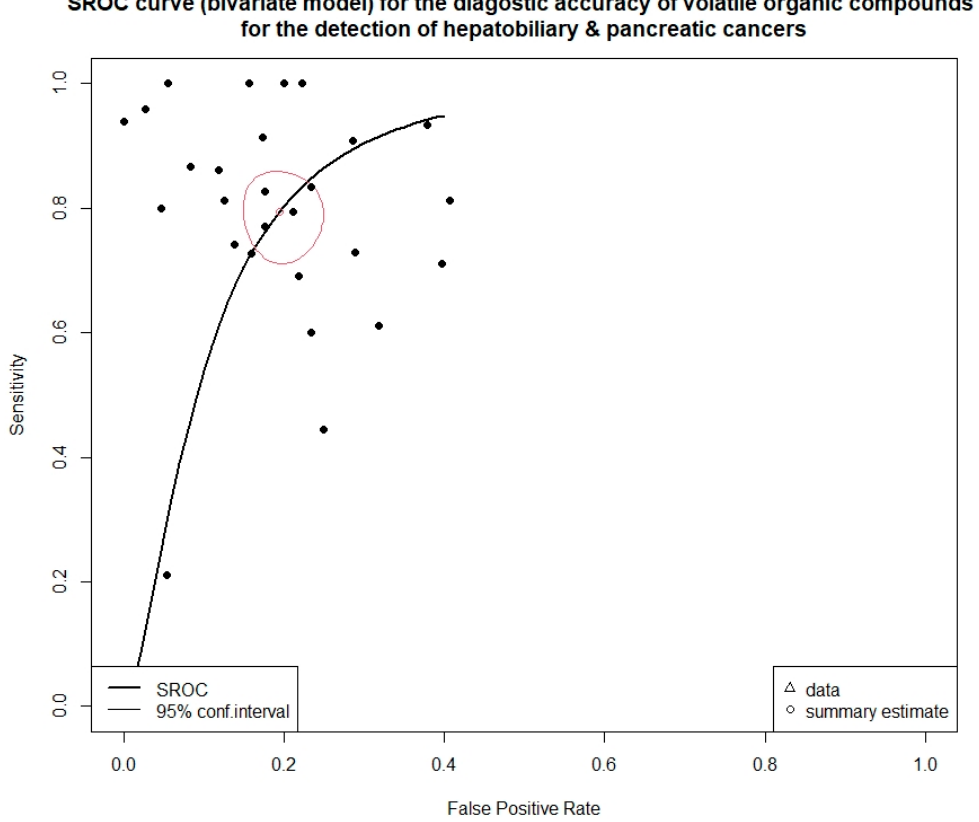
Figure 3. Summary receiver operator curve characteristics for volatile organic compounds in the detection of hepatobiliary and pancreatic cancer. The circle represents the confidence interval, and the dots represent the distribution of studies.